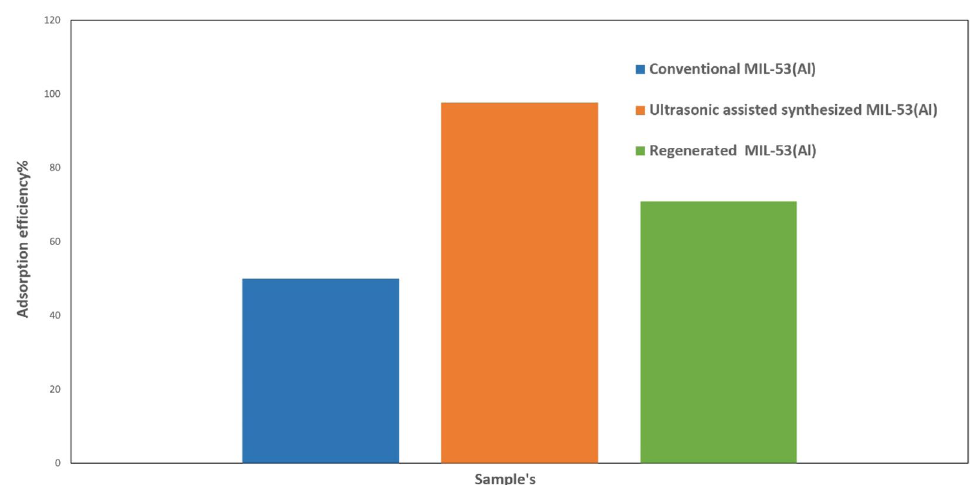
Figure 15. Comparison of adsorption parameter for Pb(II) on conventional and ultrasonic assisted synthesized and 1 cycle regeneration of